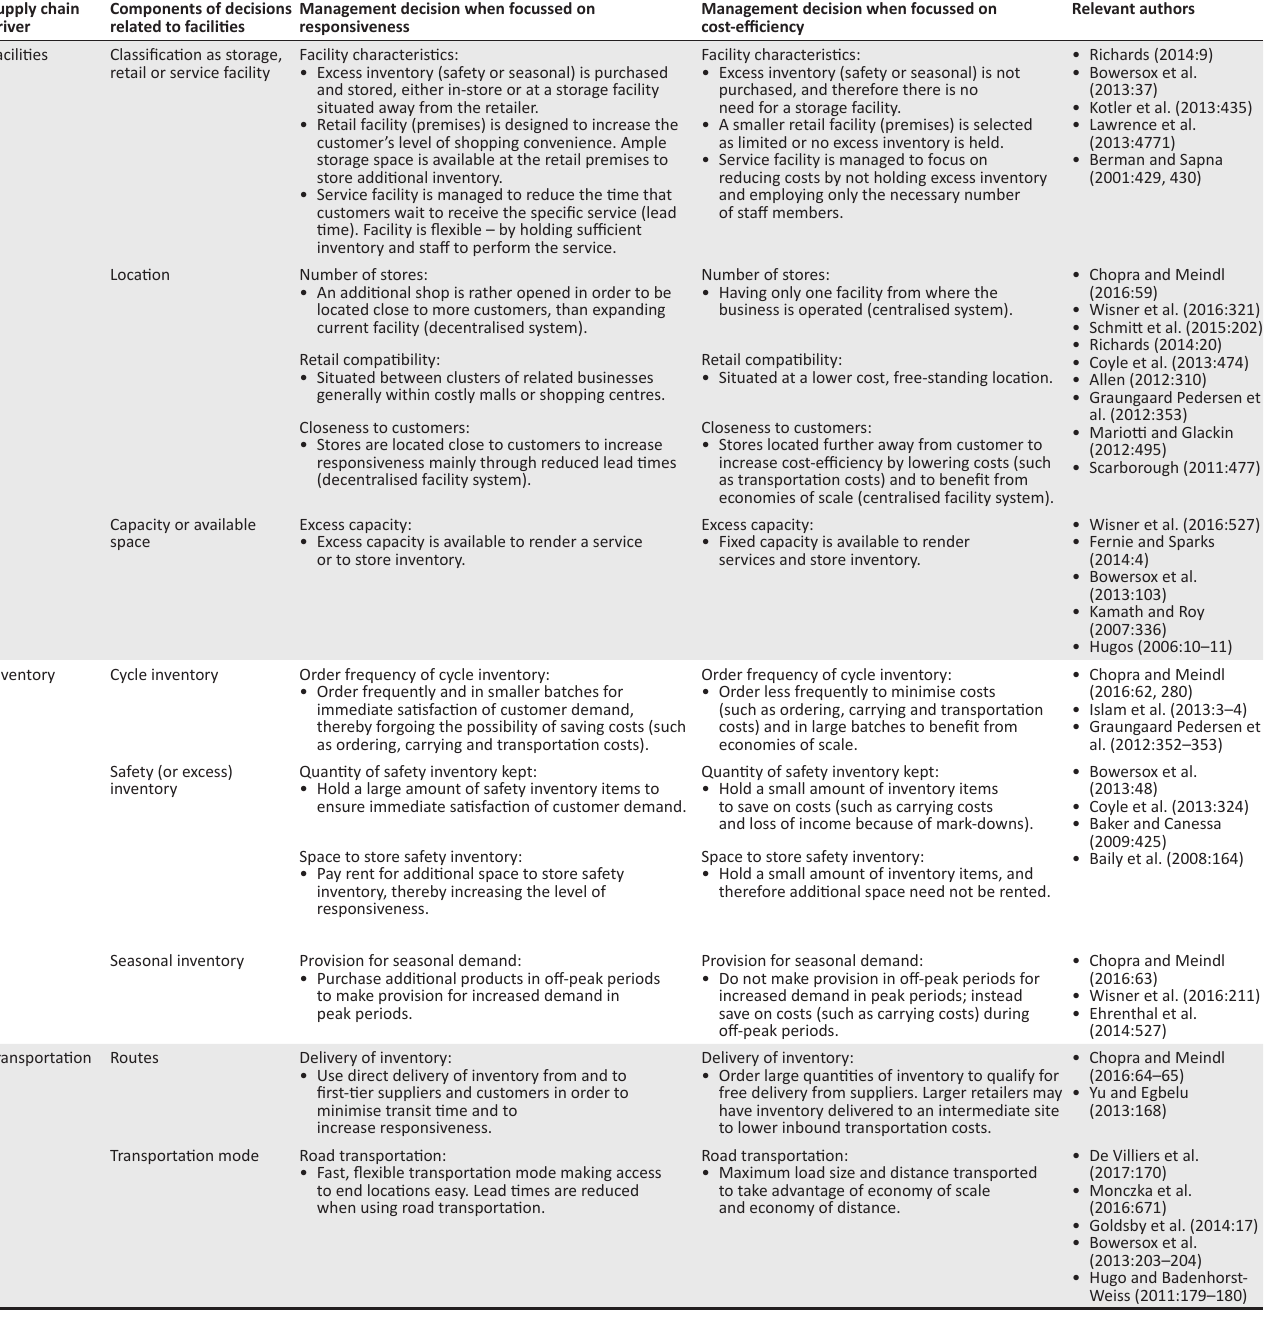
TABLE 3: Logistical supply chain drivers’ management